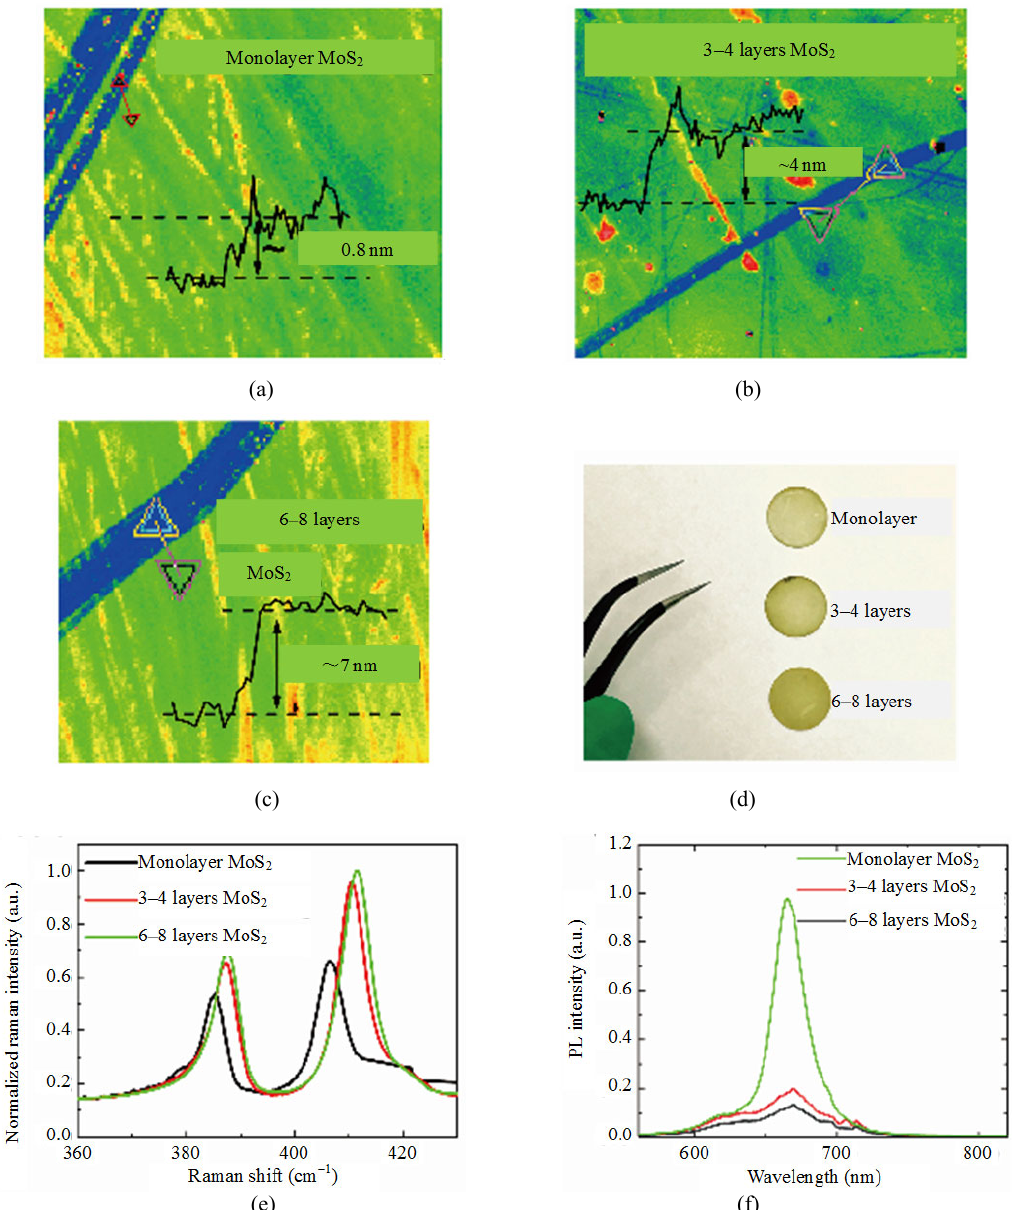
Fig. 1 White-light interferometer measurements of (a) monolayer, (b) 3 ‒ 4 layers, and (c) 6 ‒ 8 layers MoS 2 . Photographs, Raman spectra and PL spectra of these MoS 2 films are presented in (d), (e), and